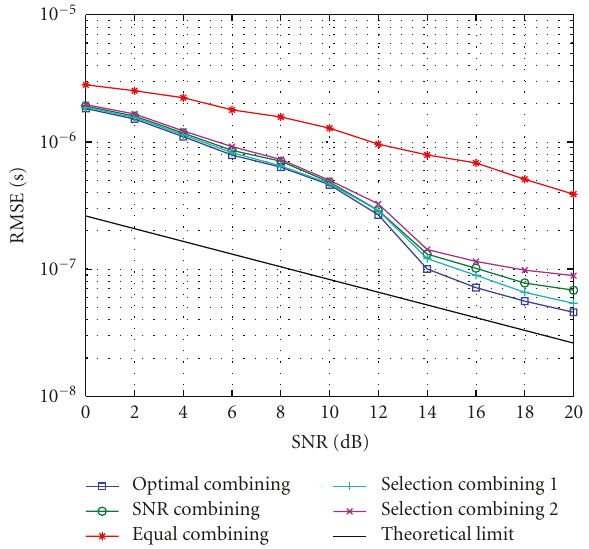
Figure 4: RMSE versus SNR for the proposed algorithms, and the theoretical limit (CRLB). The signal occupies three dispersed bands with bandwidths B 1 = 200 kHz, B 2 = 100 kHz and B 3 =